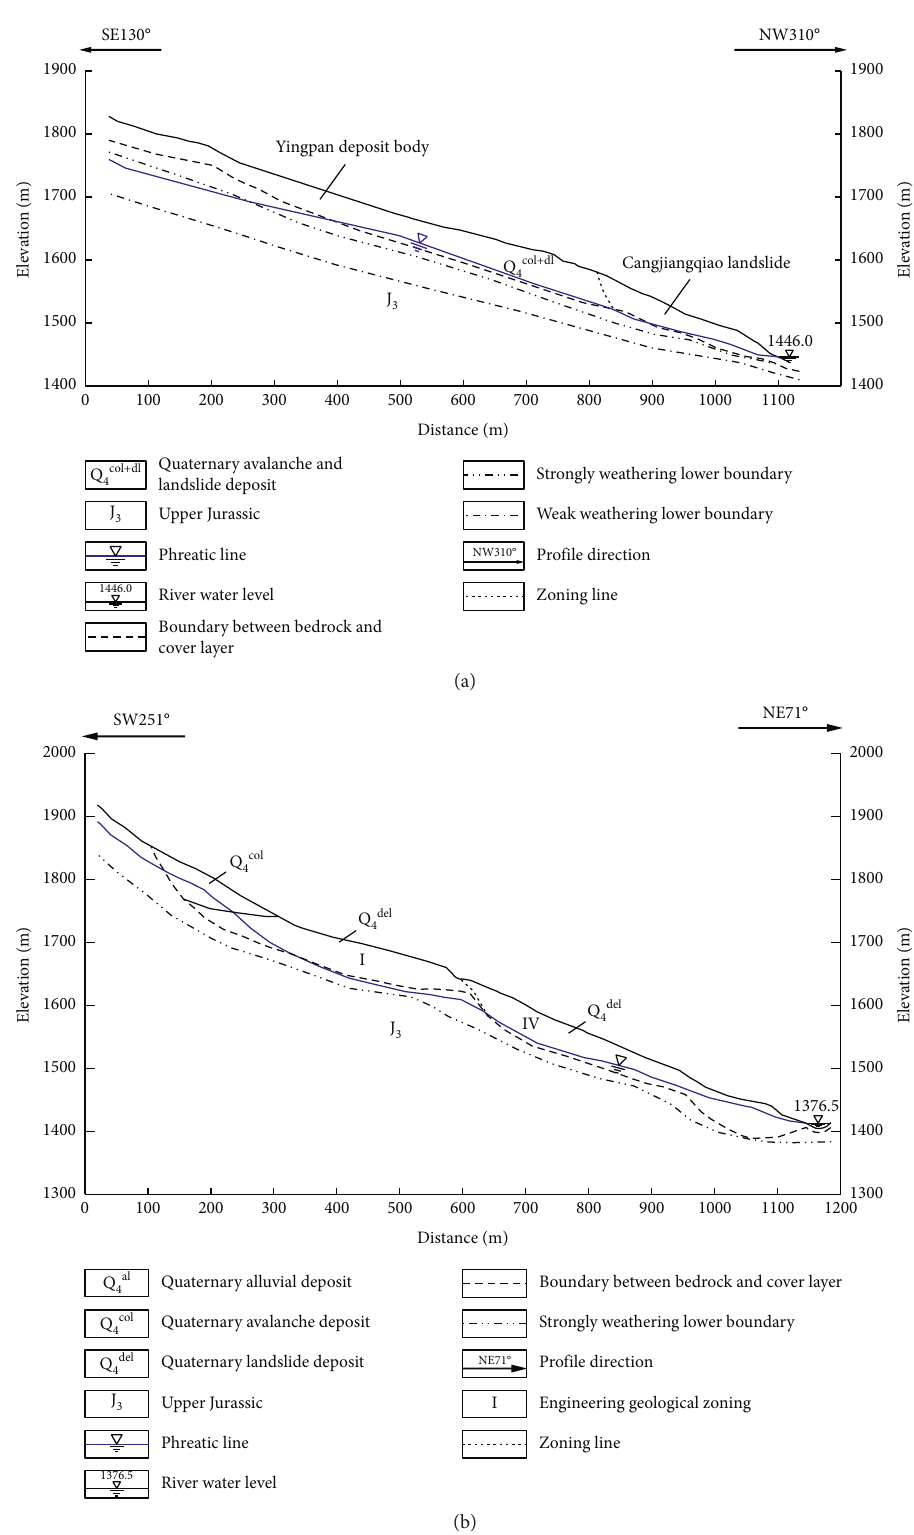
Figure 2: Typical engineering geological profiles of Cangjiangqiao and Dahua landslides. (a) Cangjiangqiao landslide. (b) Dahua